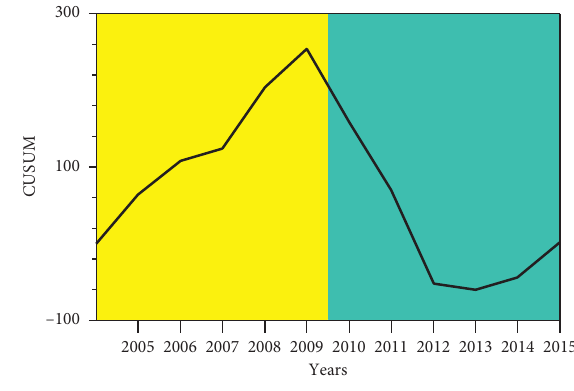
Figure 13: Mpumalanga: CUSUM